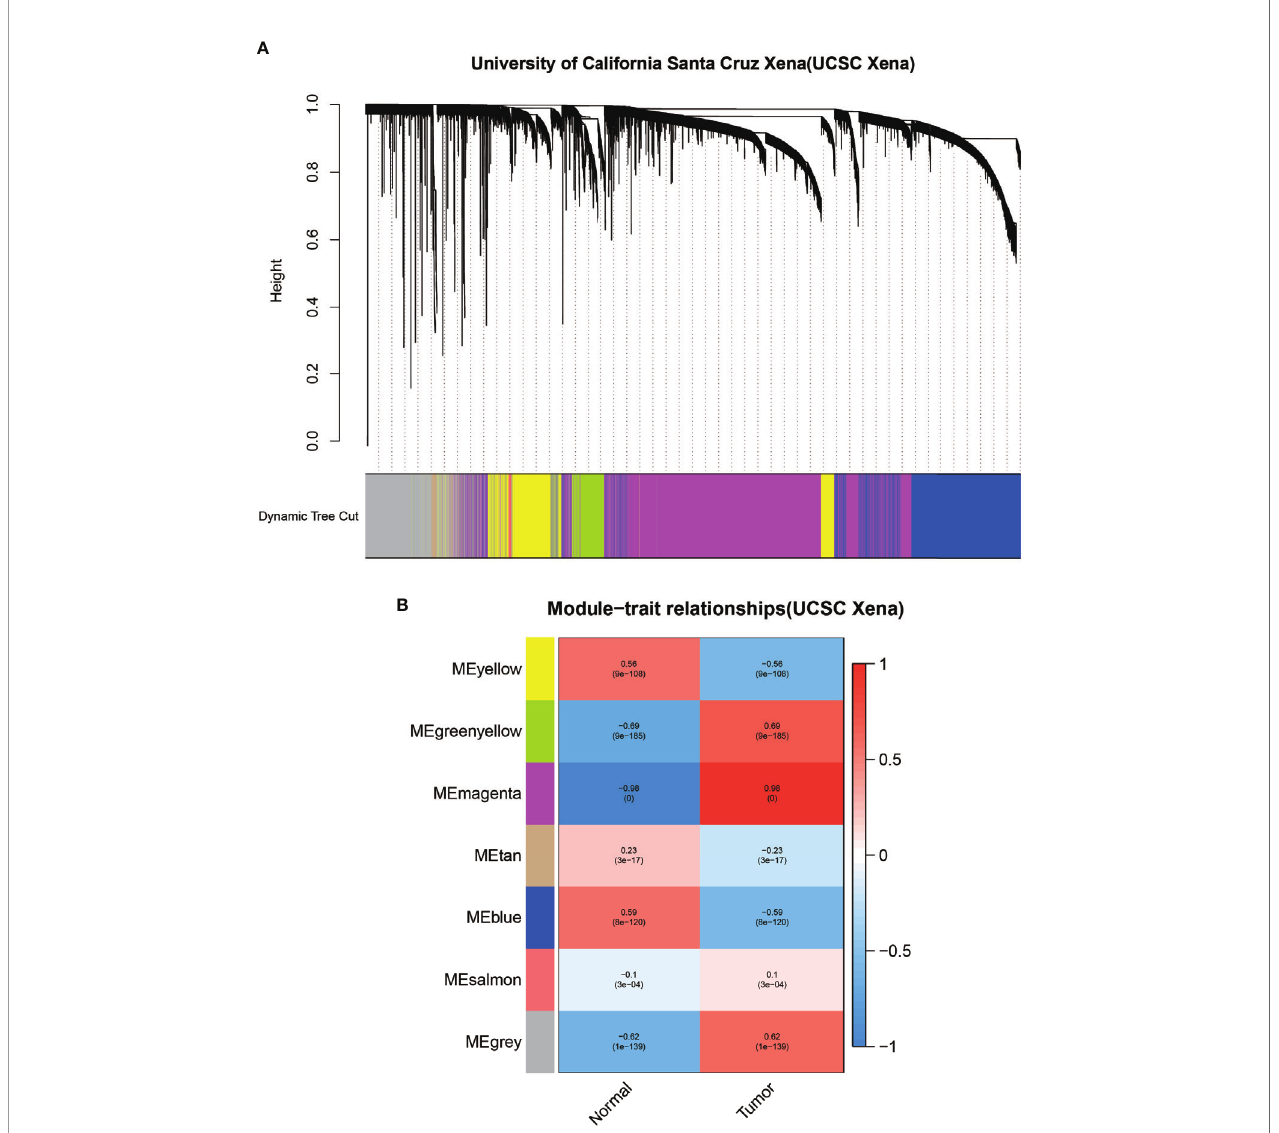
FIGURE 3 | Identi fi cation of modules associated with clinical information in the UCSC Xena database. (A) Clustered tree diagram of co-expression network modules sorted by gene-level clustering of matrices obtained by Equation 1-TOM. Each color represents a different co-expressed gene. (B) Relationship diagram of the features of the modules. Each row corresponds to a color module, and each column corresponds to a clinical feature (normal and cancer). Each cell contains the correlation and P-value of the corresponding